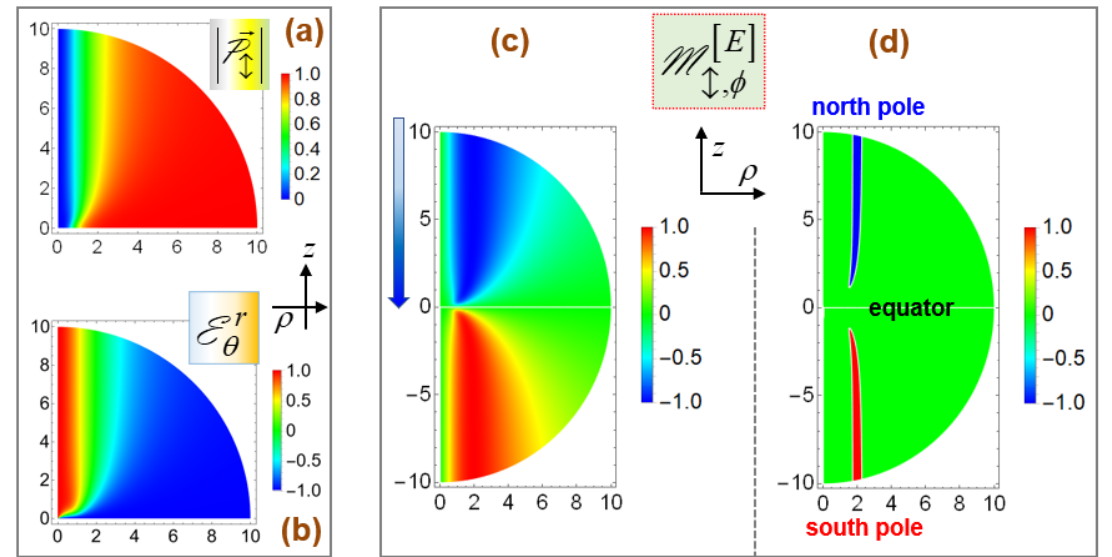
  [ ] avg → → [ avg ] P I ≡ P for a linear dipole. ( b ) The relative intensity P (cid:108) ≡ P (cid:108) / I Figure 3. ( a ) The streamlines formed by for a linear dipole. ( b ) The relative intensity Figure 3. ( a ) The streamlines formed by (cid:108)    ( ) ( ) (cid:16) (cid:17) − 1 (cid:16) (cid:17) [ E ] θ− 1 2 2 2 2 ≡ | E r | 2 + | E | 2 | E r | 2 − | E | 2 ratio E r . ( c ) The azimuthal component M of the per-electric- ≡ + − E [ ] r θ θ E E E E (cid:108) , φ θ E M of the per-electric- ratio . ( c ) The azimuthal component θ θ r r φ  [ E ] , (cid:12) (cid:12) → (cid:12) (cid:12) ≤ 1. All plots are M field-intensity vector  [ ] E (cid:108) . ( d ) Near-circular polarization states with 0.99 ≤ (cid:12) (cid:12) M (cid:108) , φ ≤ ≤ 0.99 1 M . ( d ) Near-circular polarization states with M . All plots are field-intensity vector made over r ≤ 10 for illustrating the spherical domains on a certain meridional z ρ φ ,   ρ ≤ for illustrating the spherical domains on a certain meridional z -plane. made over 10 r  [ ] E M in Equation (8) becomes a Meanwhile, the per-electric-field-intensity vector  [ ] [ ] 2 E E E M scalar φ , ,